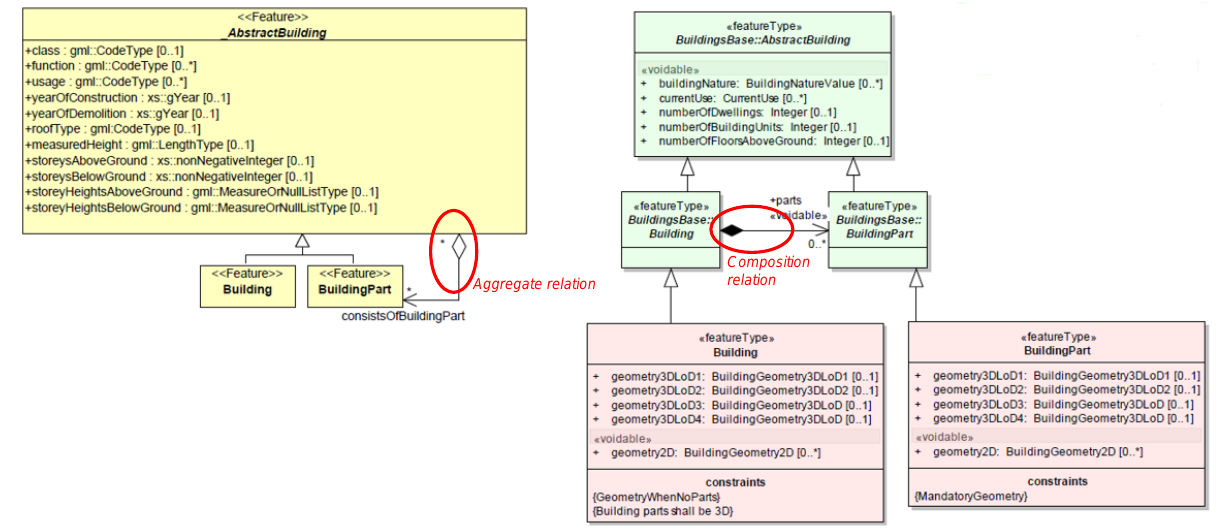
Figure 2. Building and building parts in CityGML (left) and INSPIRE Building (right)